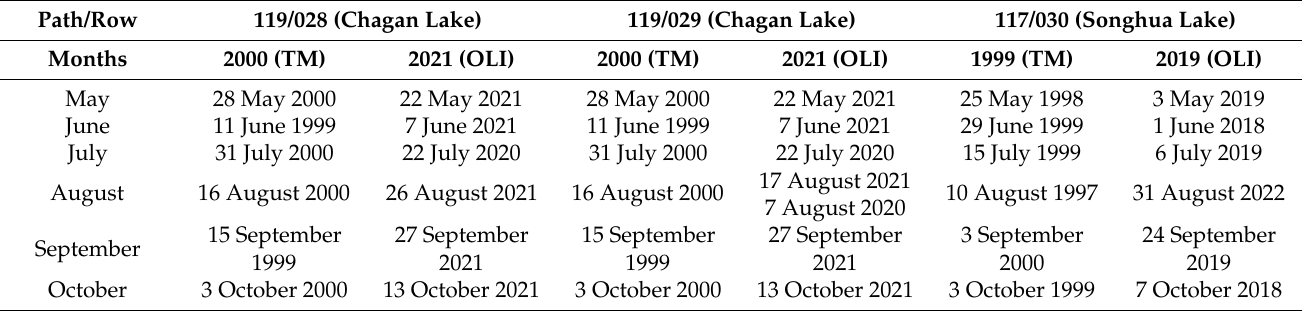
Table 2. The acquisition dates of the Landsat imagery data used to calculate water